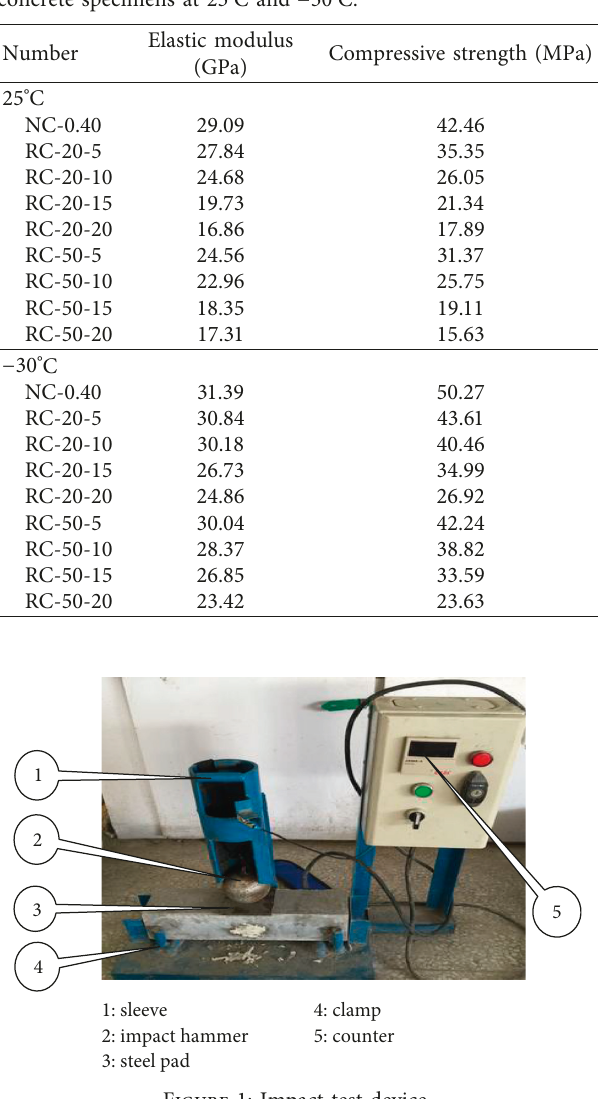
Table 7: Elastic modulus and compressive strengths of the rubber concrete specimens at 25 ° C and − 30 ° C.